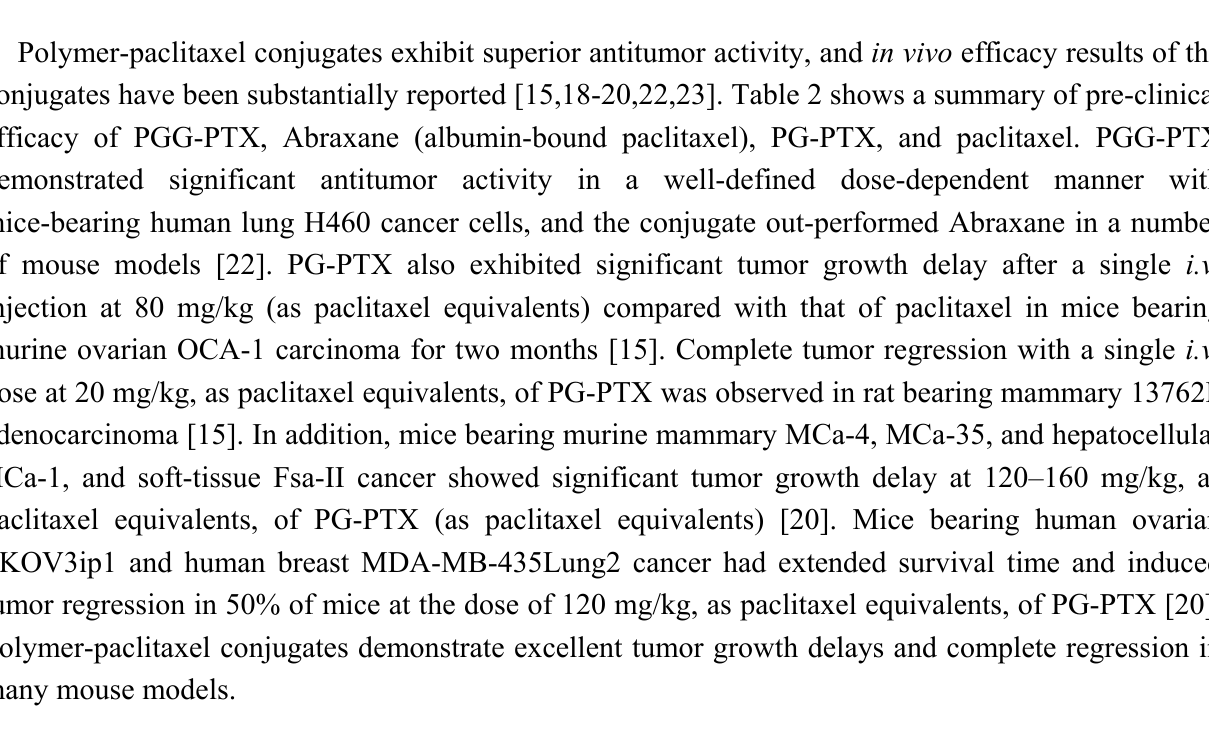
Table 1. Plasma pharmacokinetics and tumor accumulation of polymer-paclitaxel conjugates and paclitaxel in mouse